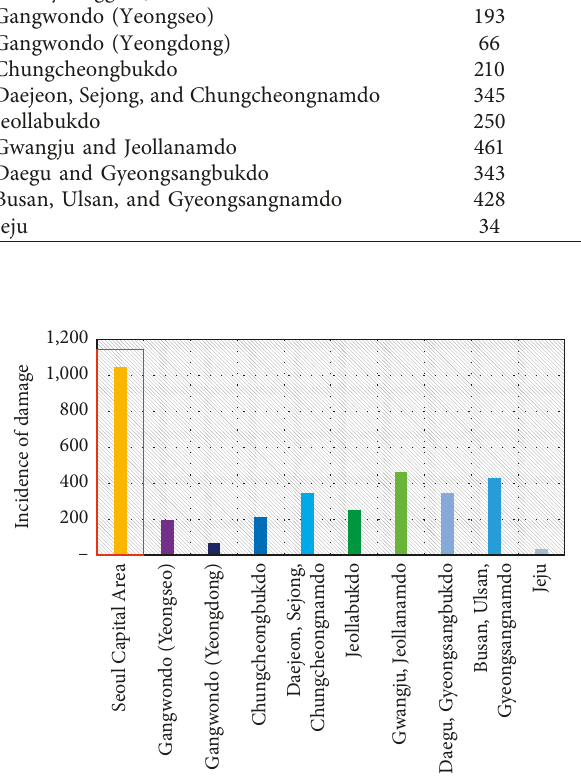
Figure 8: Incidence of heavy rain